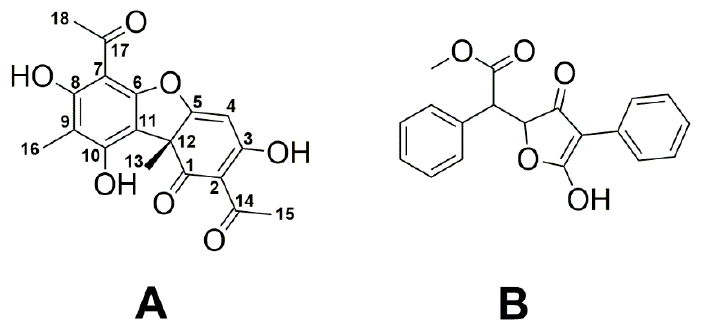
+ )-usnic acid ( A ) and vulpinic acid ( B Figure 1. Chemical structures of (+)-usnic acid ( A ) and vulpinic acid ( B ). Figure 1. Chemical structures of (